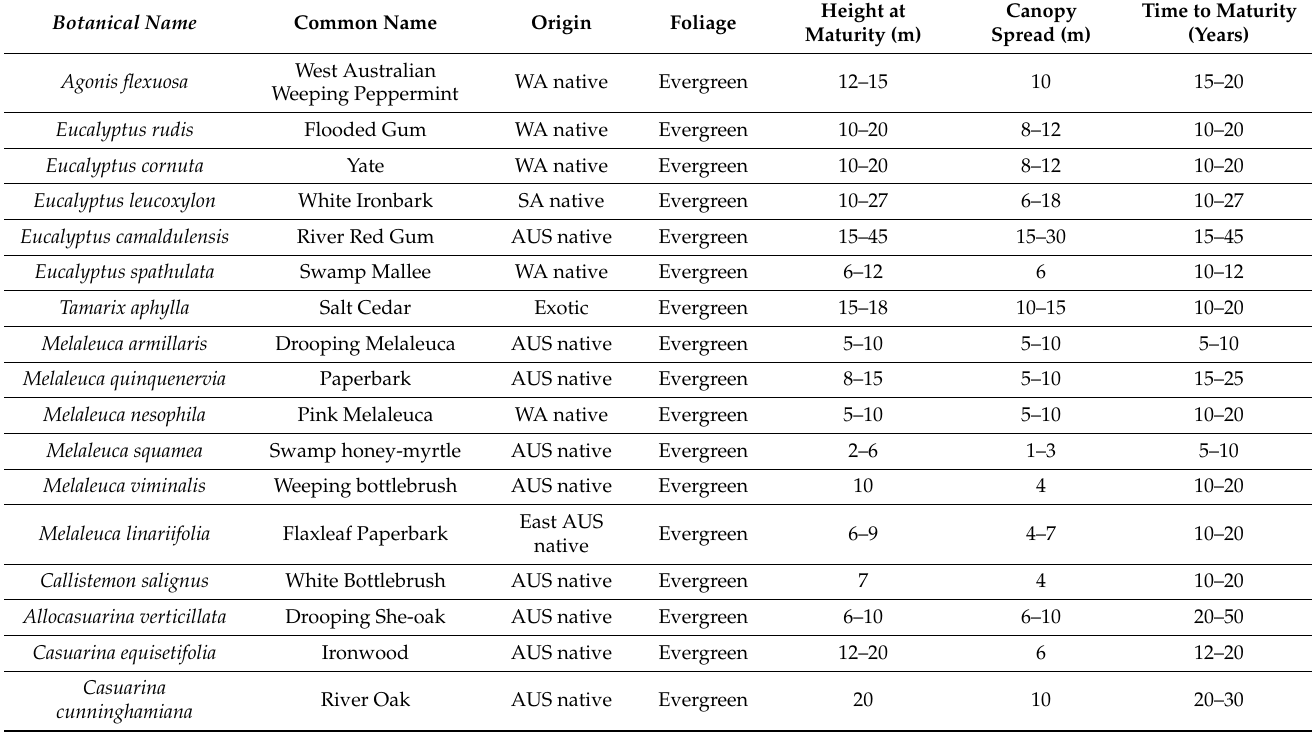
Table 4. Vegetation present